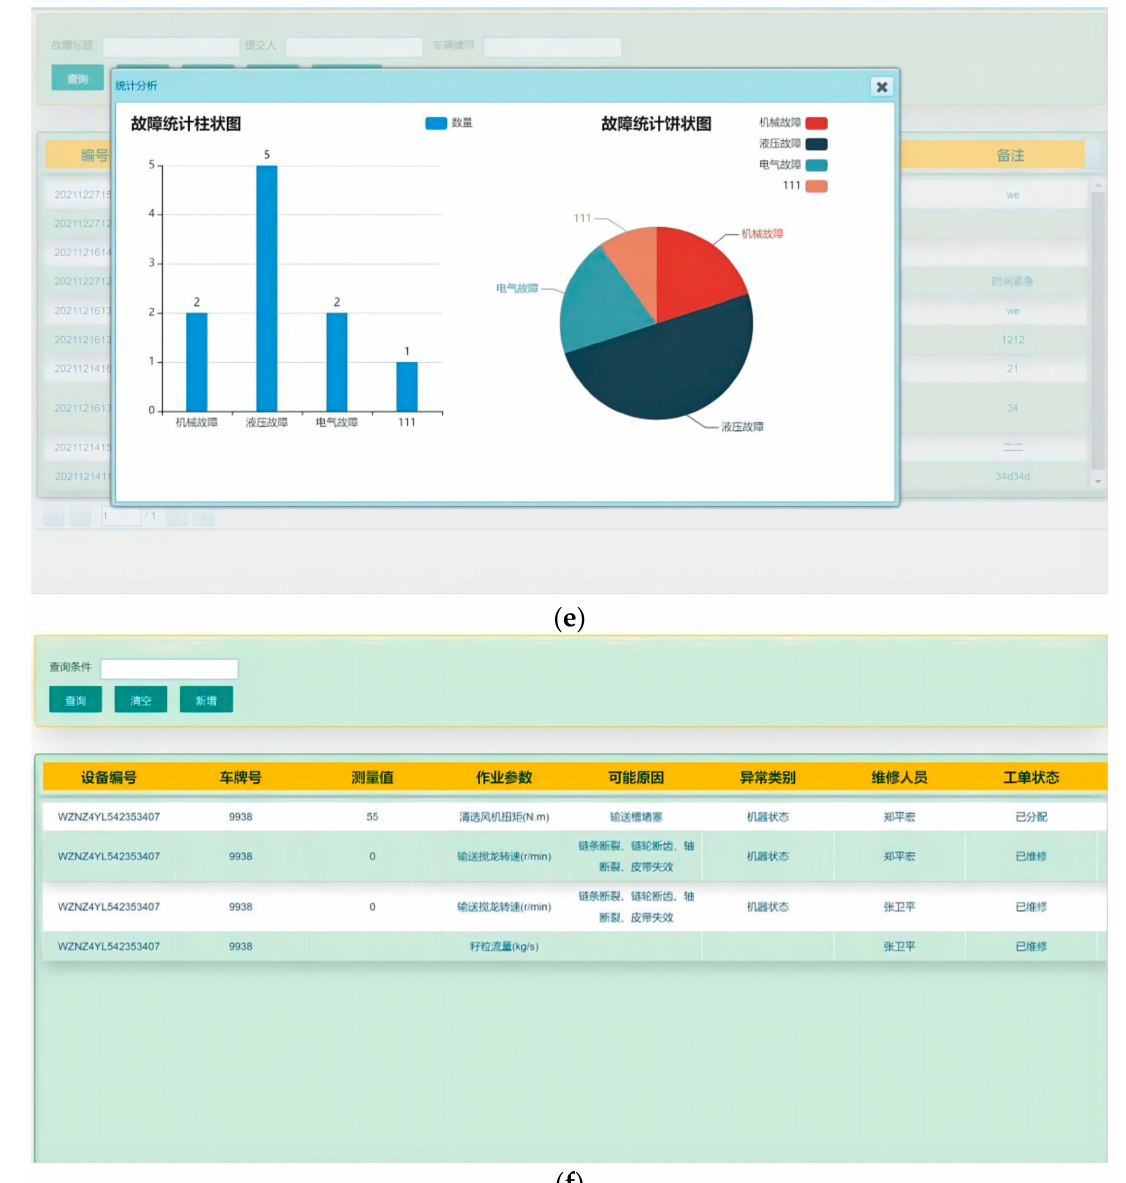
Figure 8. Platform function test: ( a ) start combine harvester vehicle terminal; ( b ) data monitoring interface; ( c ) failure prediction interface; ( d ) fault diagnosis interface; ( e ) fault diagnosis interface; ( f ) job maintenance